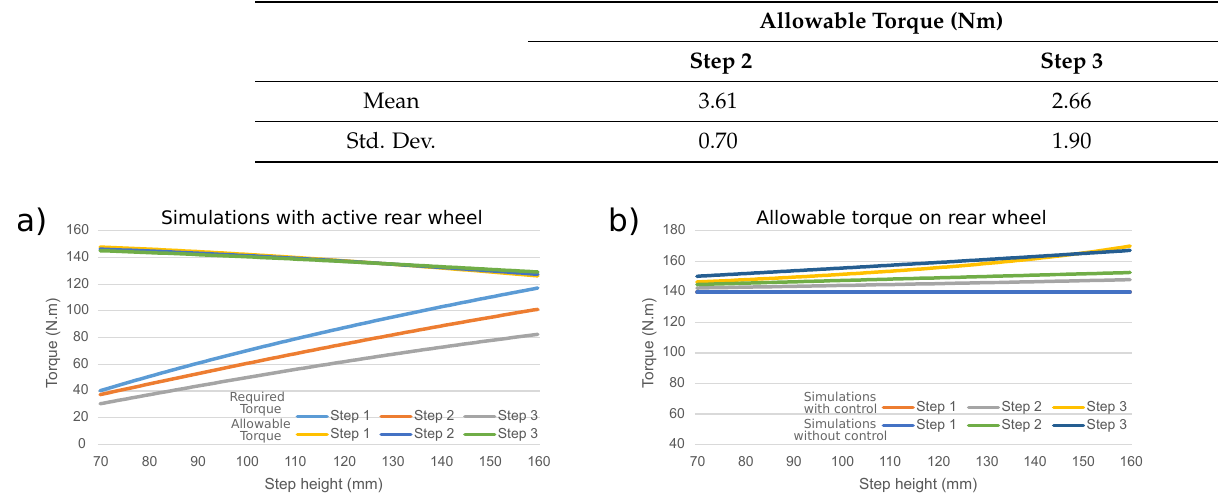
Figure 11. Simulation with an active rear wheel; ( a ) Change in allowable and required torque on front wheels to overcome a step with respect to the change in height of the step (without controlling the inclination angle); ( b ) variations in allowable torque on rear wheels when the front wheels overcome steps with the varying height of the